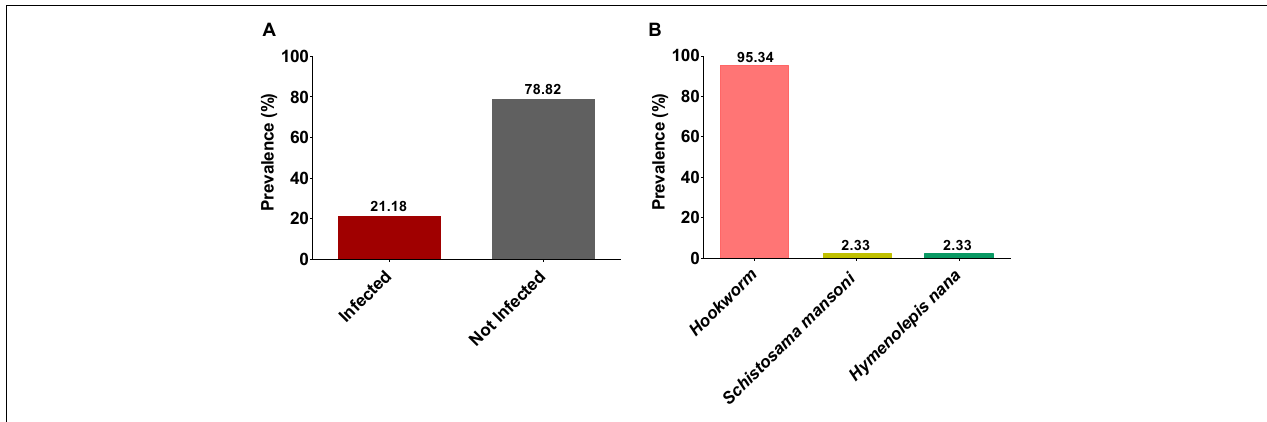
FIGURE 3 | Prevalence of helminthiasis. The bars indicate the prevalence of infected and non-infected (A) . Prevalence of each species found on the cohort: hookworm, Schistosoma mansoni , and Hymenolepis nana (B) .